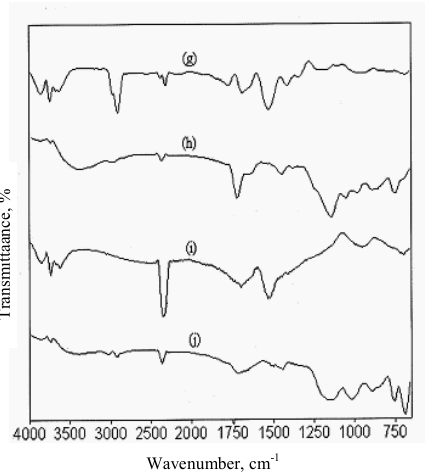
Figure 2. (g) PMMA (h) S-PMMA (i) SMMA (j)